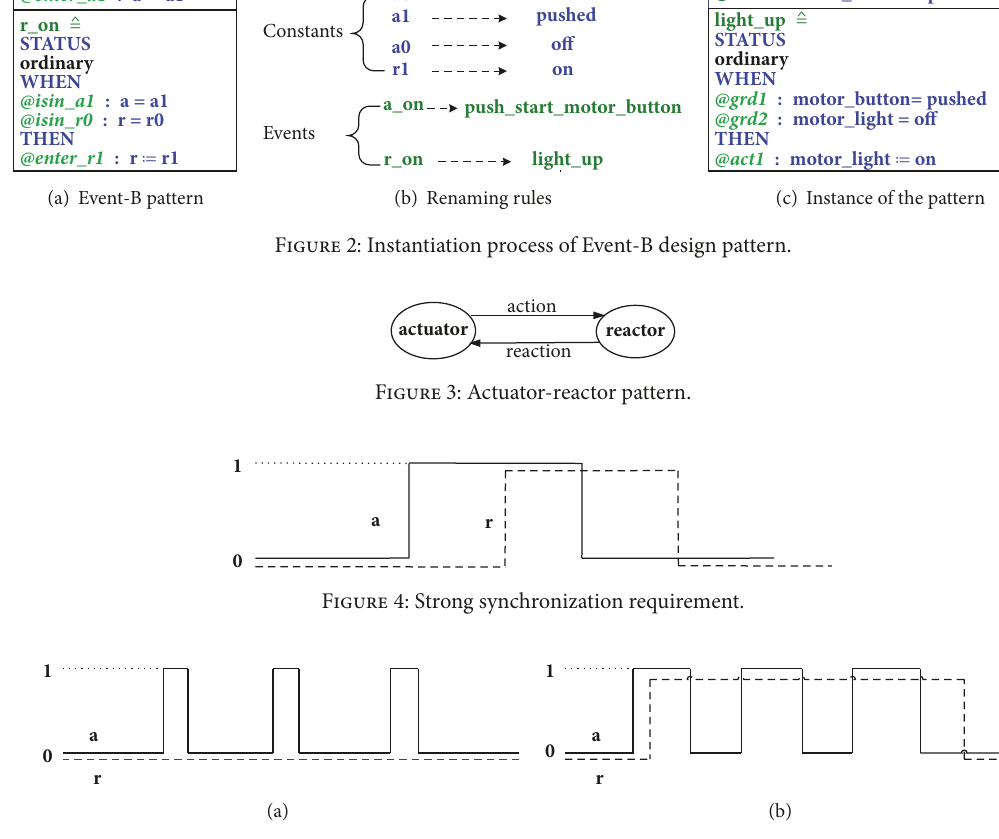
Figure 5: Weak synchronization